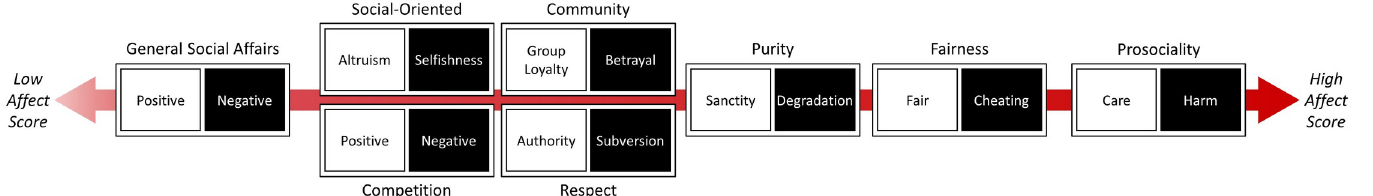
Fig 2. Social domains used in the current study. Eight different social domains (with their positive and negative components) used in the current study and their relative positions from lower to higher significance, in terms of right and wrong, good and bad behavior, and potential impact. Five morality domains (prosociality, fairness, community, respect, and purity) were adopted and modified from the moral foundations theory [76–79].The remaining three (competition, social-oriented, and general social affairs) were selected to represent other social activities.